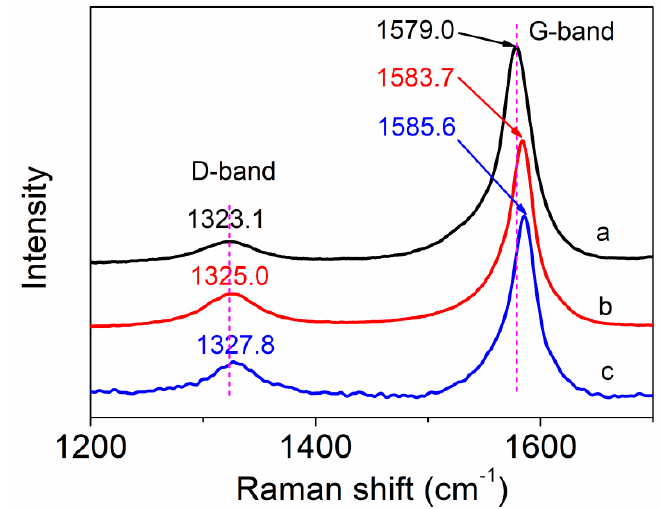
Figure 3. Raman spectra of ( a ) purified MWCNTs, ( b ) amino ‐ MWCNTs and ( c ) PAN grafted amino ‐ MWCNT nanocomposites.